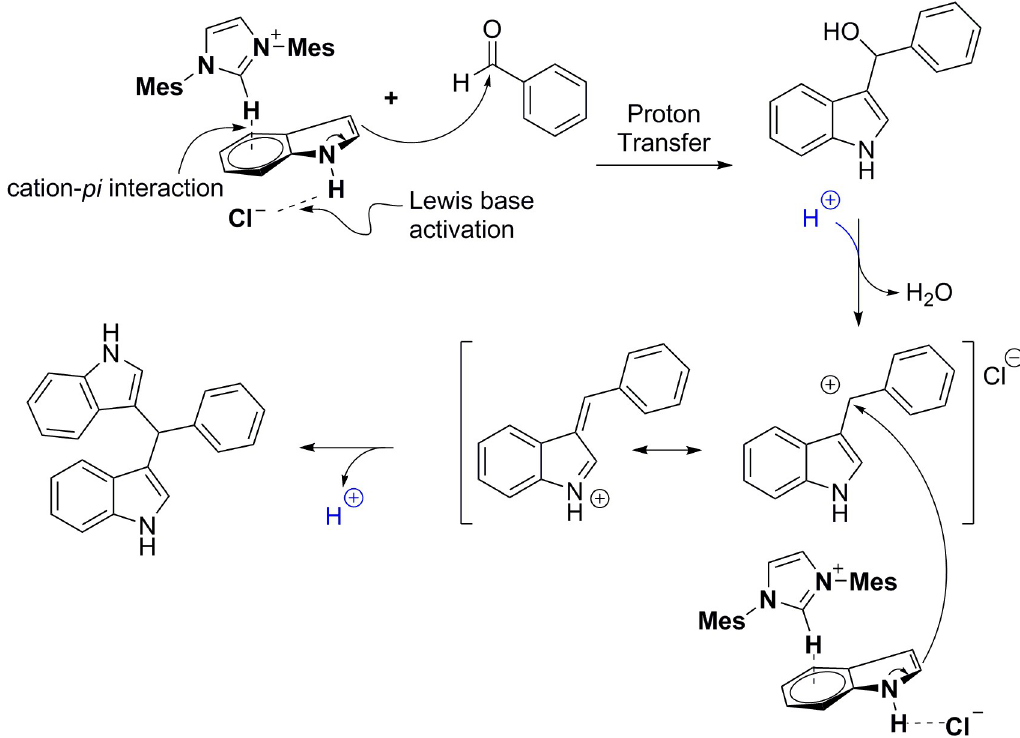
Fig 8. Proposed reaction